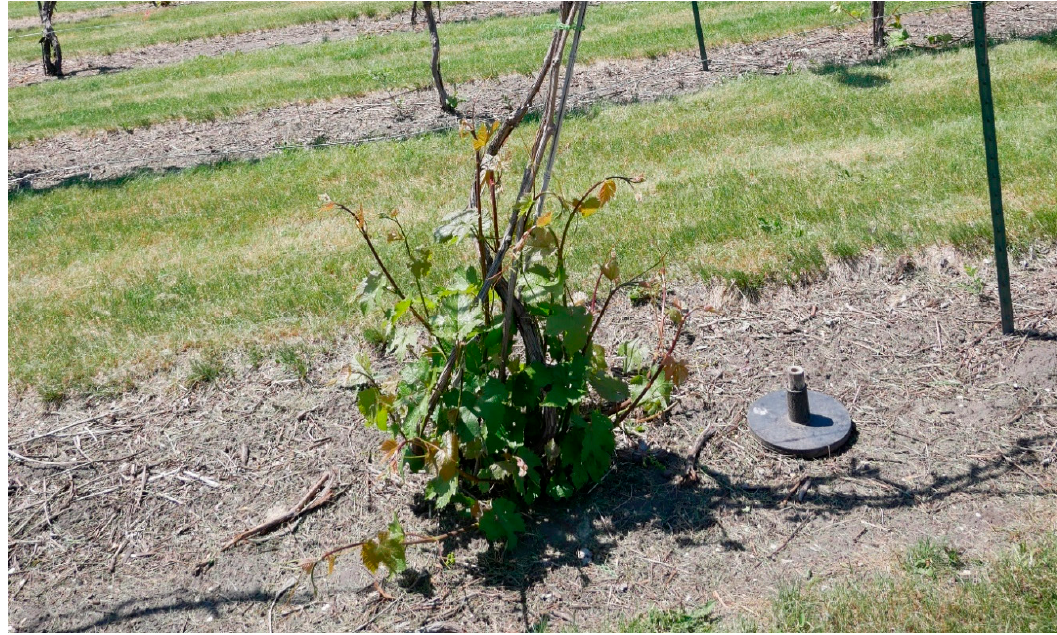
Figure 3. Suckers of “La Crescent” prior to thinning and training in the grape variety trial located at the NDSU Horticulture Research Farm near Absaraka, ND, USA.